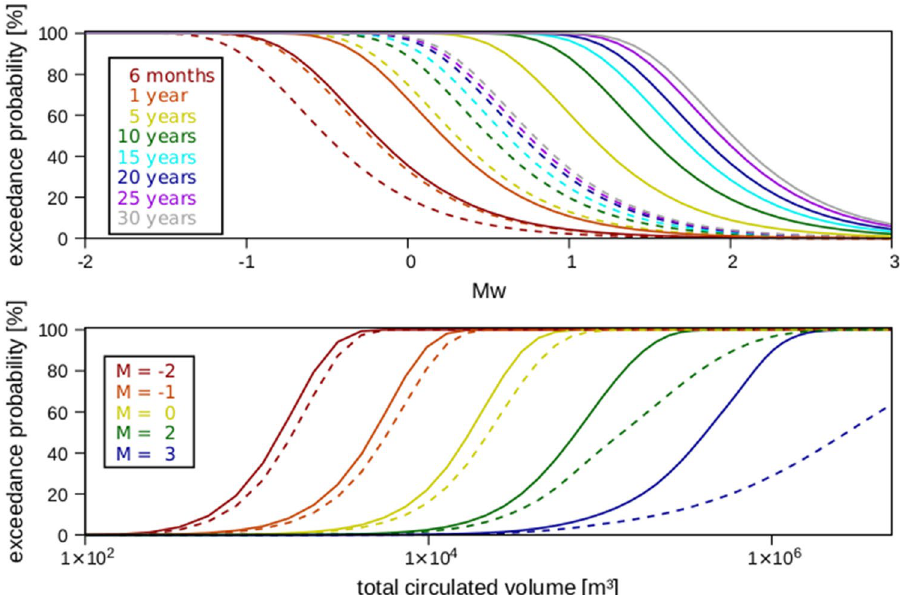
Figure 4. Cumulative exceedance probability of a given magnitude Mw (upper panel) and its evolution as a function of the total circulated volume (lower panel) in a geothermal well doublet during 30 years of continuous injection and production. Continuous curves indicate cases for which thermo-poroelastic effects are considered, and dashed curves indicate cases for which these additional effects are disregarded. The difference between the curves increases with time and peaks after pore pressure equilibrates in the system.